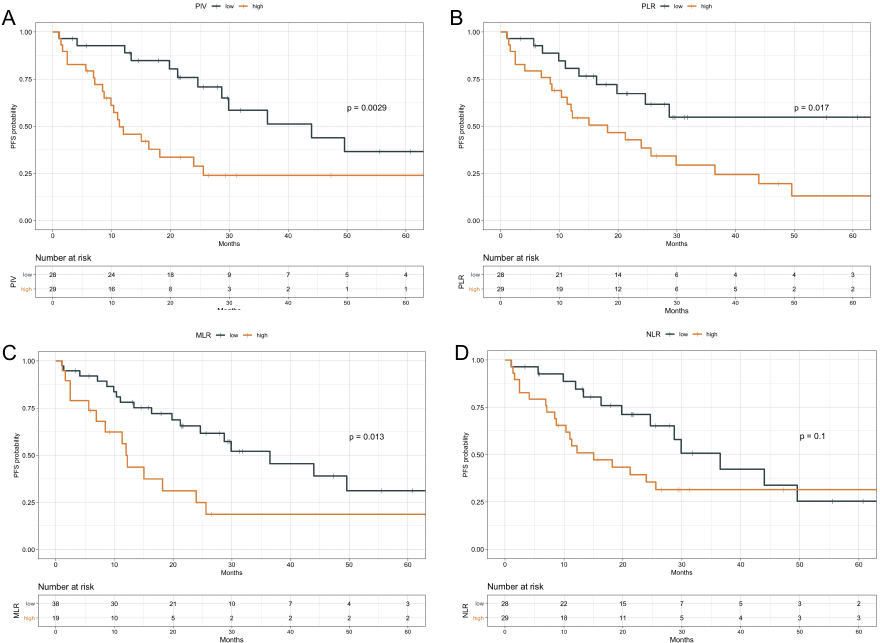
Figure 1. Progression Free Survival according to baseline PIV, PLR, MLR and NLR values. Kaplan– Meier curves representing patient PFS according to baseline PIV ( A ), PLR ( B ), MLR ( C ), and NLR ( D ) categories. The median value of each parameter was used as a threshold for the definition of the parameter categories (high vs. low). PFS: Progression-free survival; PIV: Pan-Immune -Inflammation Value; MLR: monocyte to lymphocyte ratio; PLR: platelet to lymphocyte ratio. NLR: neutrophil to lymphocyte ratio. The I symbol indicates patients censored at the time of data cut off and analysis. At univariate analysis, other factors associated with worse PFS were a higher number of metastatic sites, the presence of visceral metastases, and prior (neo)adjuvant therapy NLR and PLR, NLR and MLR, and PLR and MLR (Table S2), the PIV, which